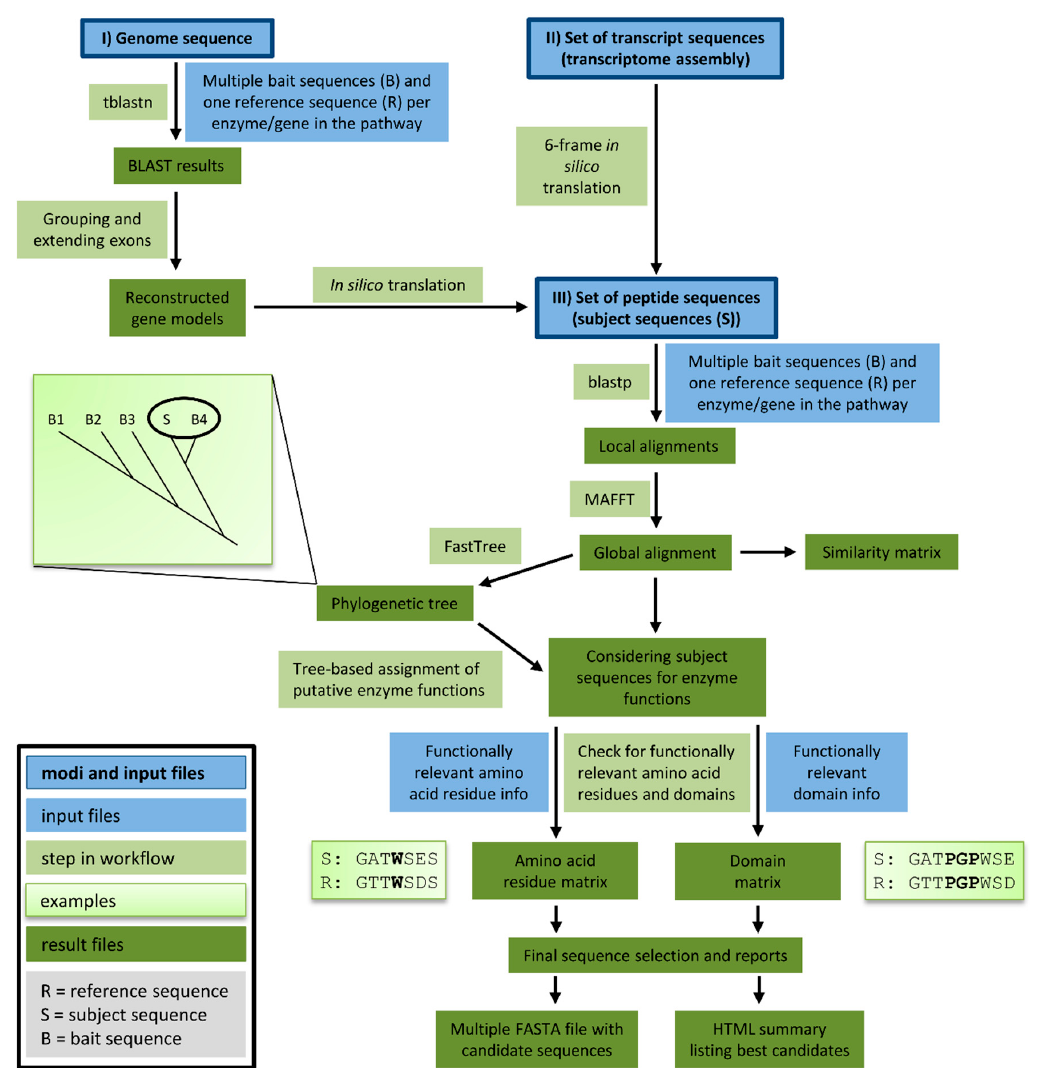
genome sequences for candidate sequences. Bait sequences and information about functionally relevant features (blue) are supplied by the user. Different modules of KIPEs (light green) are executed consecutively depending on the type of input data. Intermediate results and the final output (dark green) are stored to keep the process